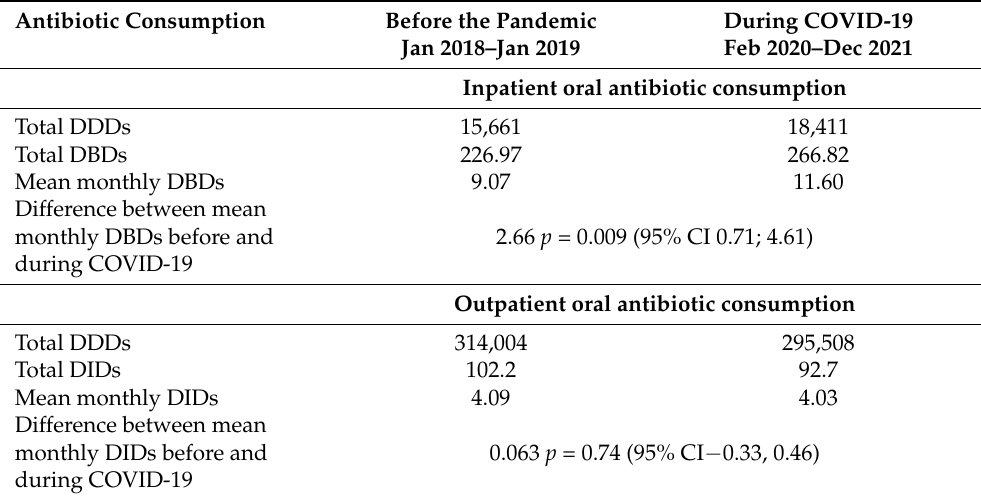
Table 2. Defined daily doses (DDDs) prescribed to inpatients and outpatients at Vila Central Hospital, Vanuatu before and during COVID-19: January 2018 to January 2020 and February 2020 and December 2021, respectively, with difference in mean monthly consumption before and during COVID-19. Antibiotic Consumption Before the Pandemic During COVID-19 Inpatient oral antibiotic